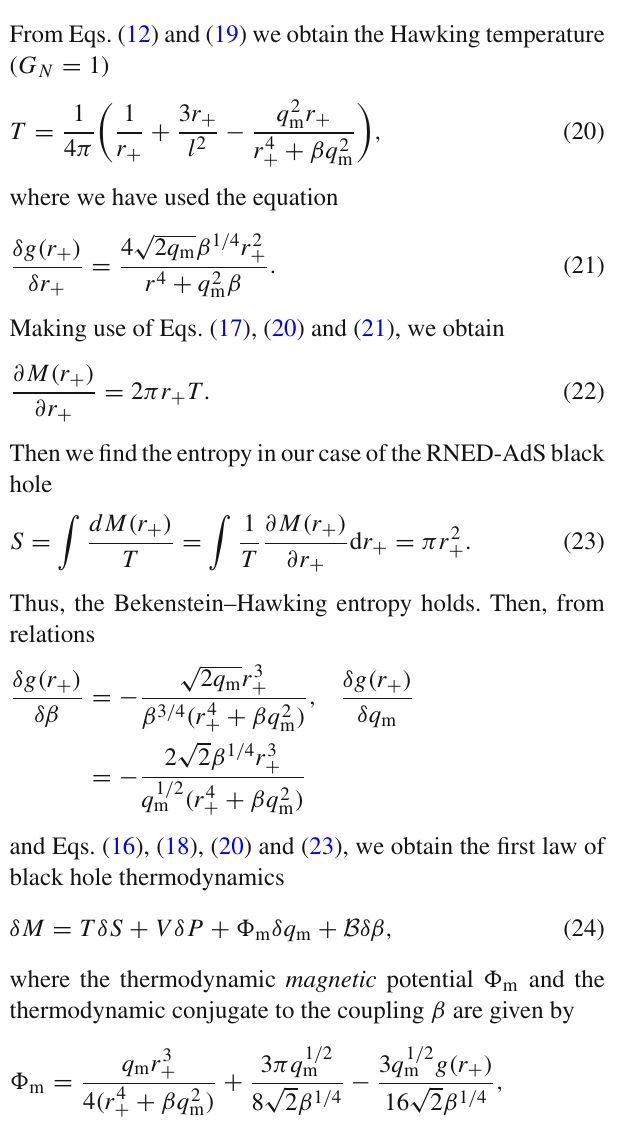
Fig. 3 The plot of vacuum polarization B vs r + at q m = 1. The solid curve is for β = 0 . 05, the dashed curve corresponds to β = 0 . 1, and the dashed/dotted curve corresponds to β = 0 .